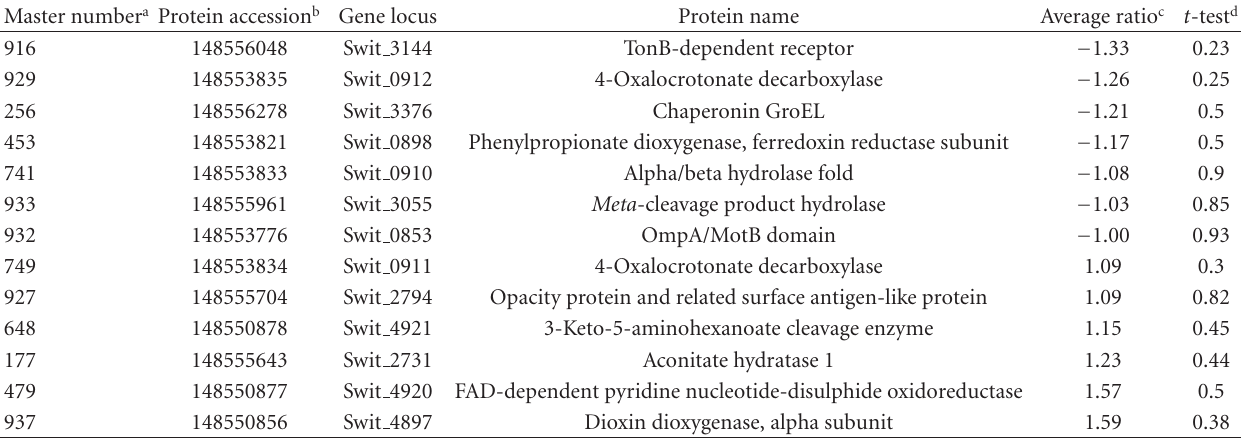
Table 3: Highly abundant proteins identified as unchanged in S. wittichii RW1 during growth on dibenzofuran or acetate. The spots were identified on a minimum of 6 gel images. Master number a Protein accession b Gene